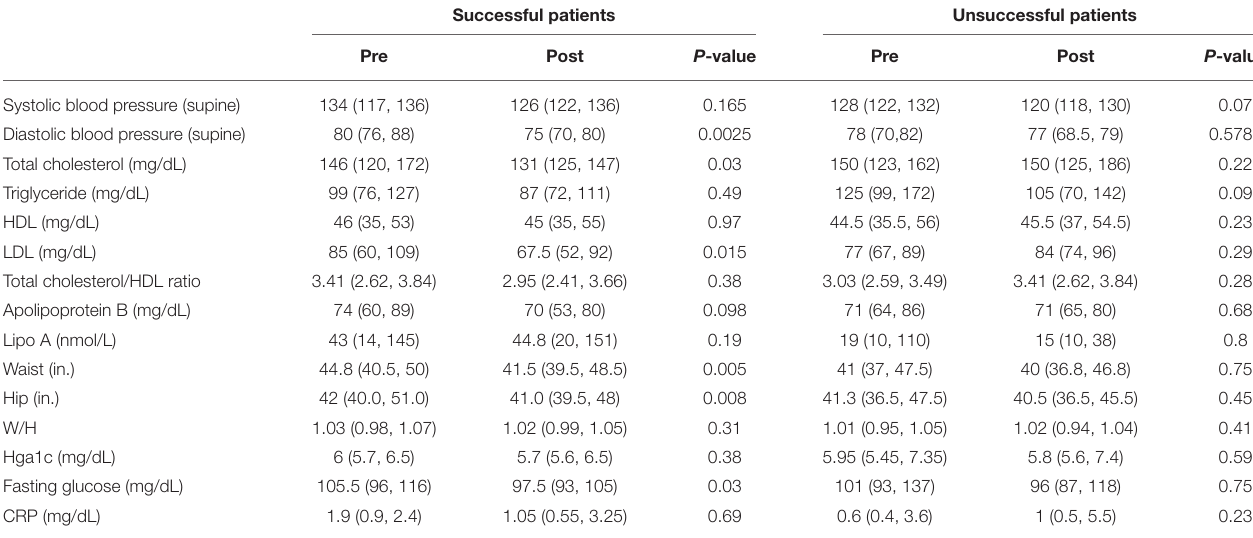
TABLE 3 | Changes in blood pressure, lipids, metabolic parameters, and high-sensitivity C-reactive protein. Successful patients Unsuccessful patients